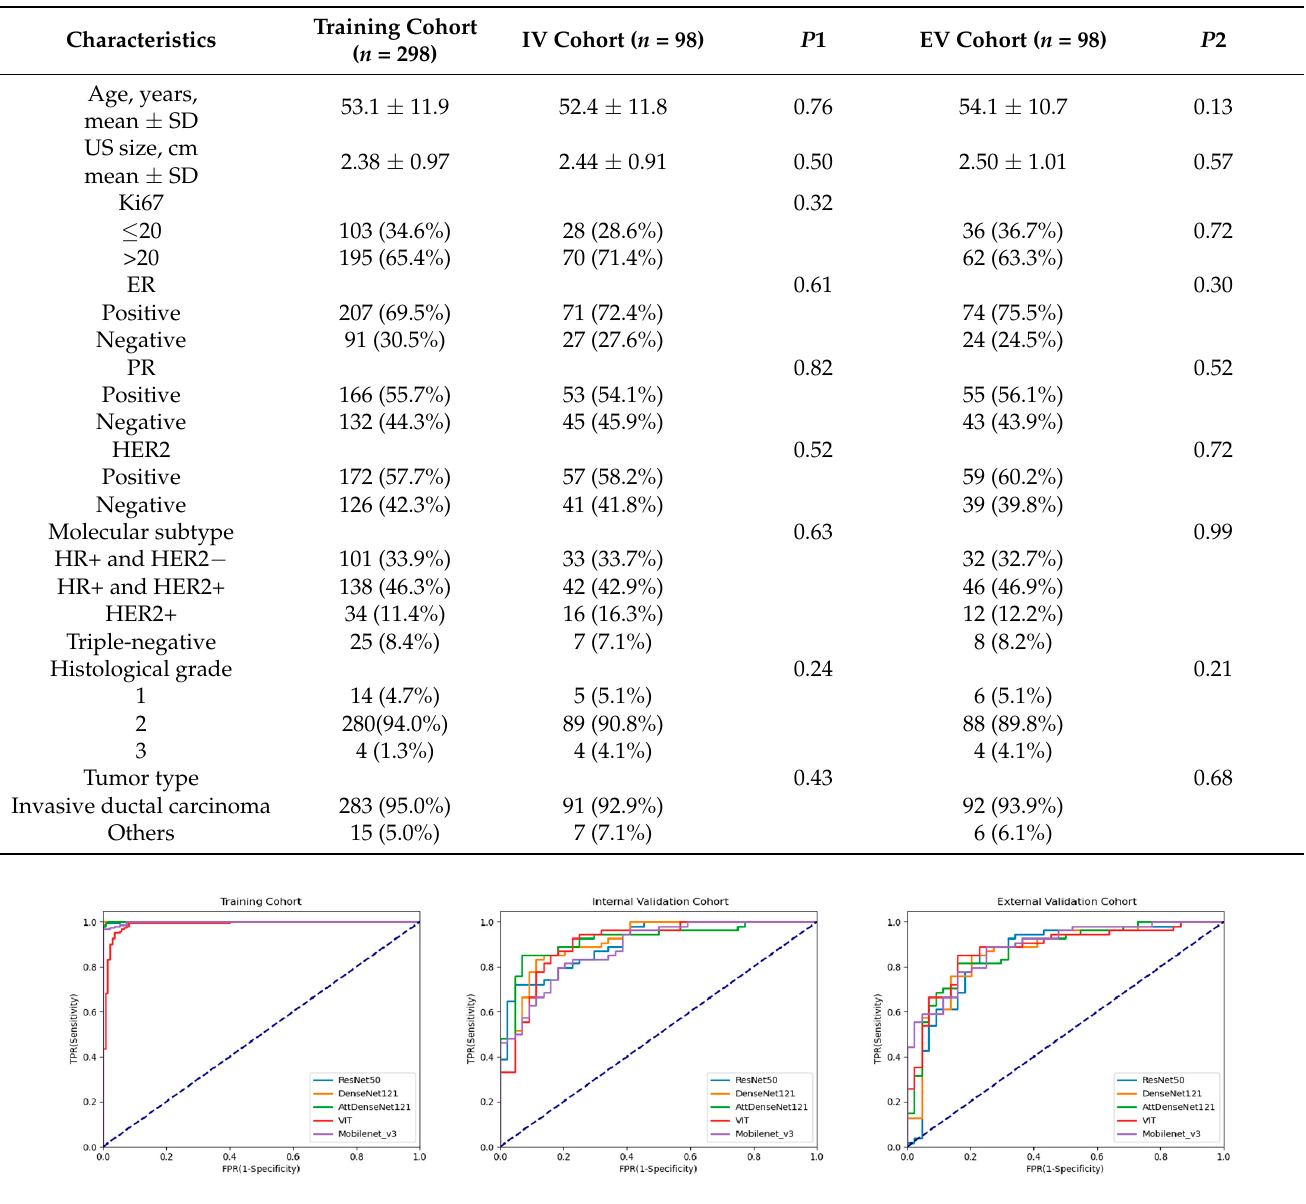
Table 1. The clinical-pathological characteristics of the patients.